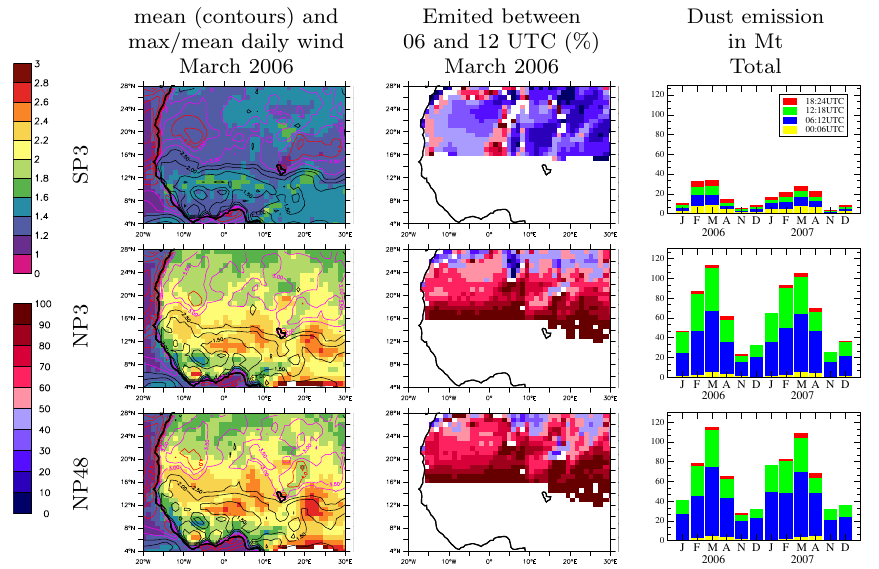
Figure 10. Diurnal cycle of winds and emission for the SP3 (top), NP3 (middle) and NP48 (bottom) simulations. The first two columns correspond to March 2006. The first one displays the mean wind (contours) as well as the monthly mean of the ratio of the daily maximum to averaged wind (color shading). The second column shows the fraction of emission that occurs between 06:00 and 12:00UTC. The right column shows for the dry-season months of years 2006 and 2005 the total African emission and its distribution between consecutive slots of 6h within the